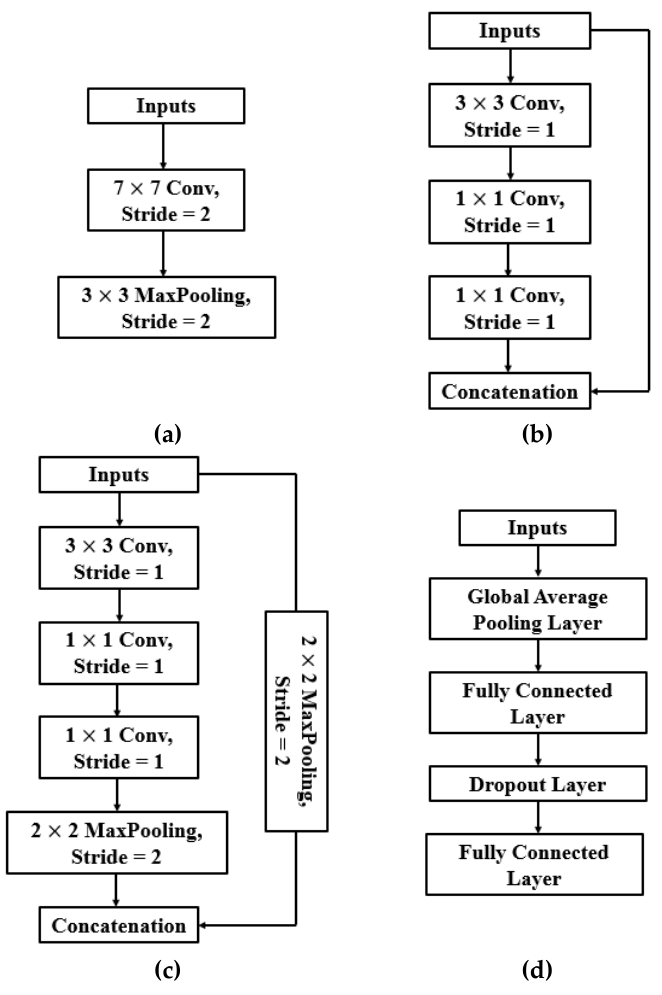
Figure 6. Building blocks of the Weakly DenseNet. ( a ) initial building block, ( b ) and ( c ) intermediate building blocks, ( d ) final classification building block .